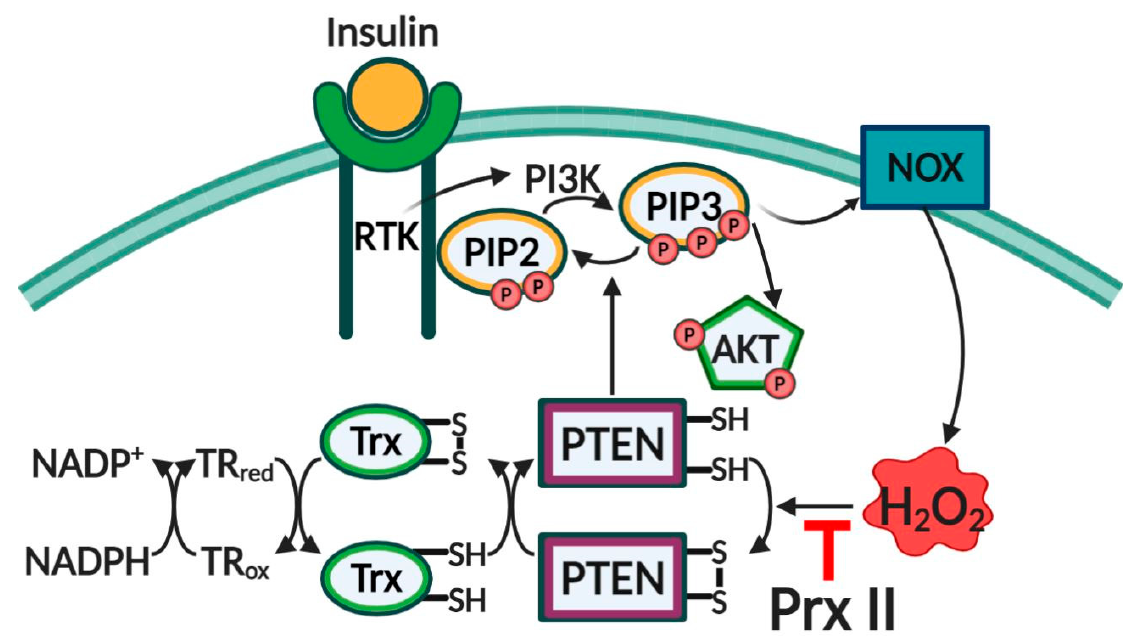
Figure 3. Role of Prx II in the redox regulation of PTEN. Insulin induced the activation of PI3K, resulting in the conversion of PIP2 to PIP3. PIP3 induced the production of H 2 O 2 by activating the NOX complex. NOX-induced H 2 O 2 oxidized PTEN and started the forming of the intramolecular disulfide bond, which inactivates PTEN lipid phosphatase. The presence of Prx II reduced PTEN oxidation levels. Black arrows (activating), red arrows (blocking).